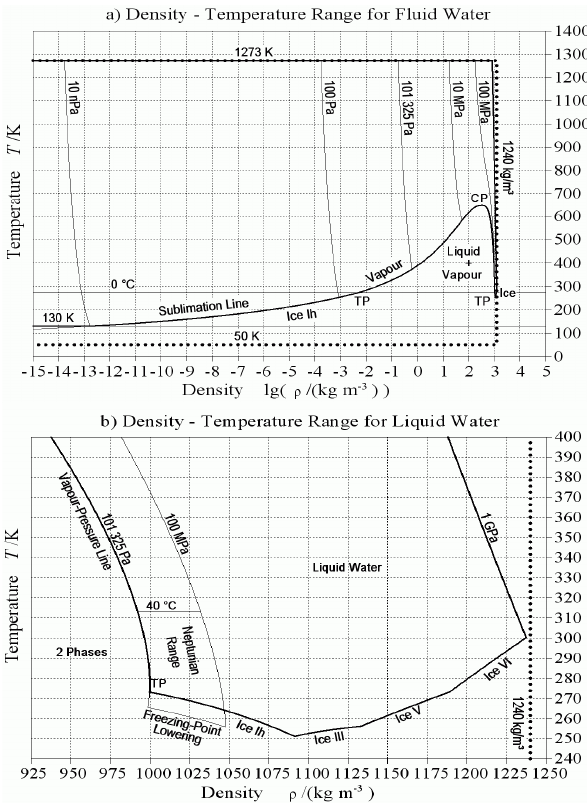
Fig. 5.1: Panel a) The validity region of the IAPWS-95 Helmholtz potential for fluid water is shown as the bold lines; the temperature bounds are connected by thinner lines indicating a selection of isobars. The heavy dotted lines indicate the range checks implemented in the library code. Panel b) A magnified view of the small region corresponding to the standard oceanographic (“Neptunian”) range. TP: triple point gas-liquid-solid, CP: critical point. The bold lines show the density and temperature bounds for validity of IAPWS-95 in this region. The deviation of the vapour-pressure line from the 101325Pa isobar in the liquid region is below the graphical resolu- tion. Freezing-point lowering occurs with the addition of sea salt. To deal with this effect in the case of seawater, the extension of the pure water properties into the metastable liquid region just above the line marked “Freezing Point Lowering” is required. The heavy dotted line to the right shows the only range check boundary im- plemented in the library routines that falls in the range shown here. (Figure adapted from Fig. 1a,b of Part